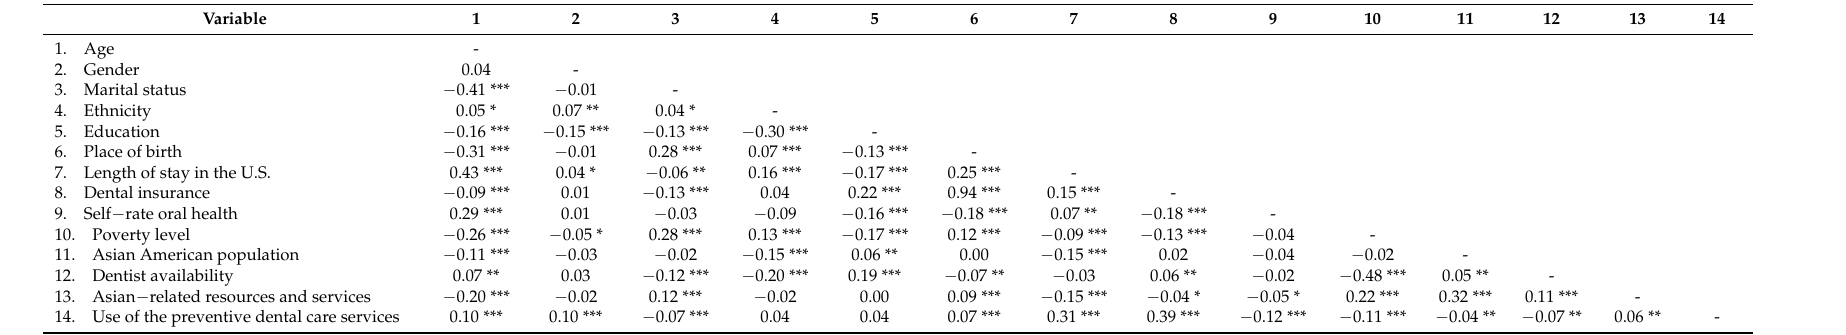
Table 2. Correlations Among Study